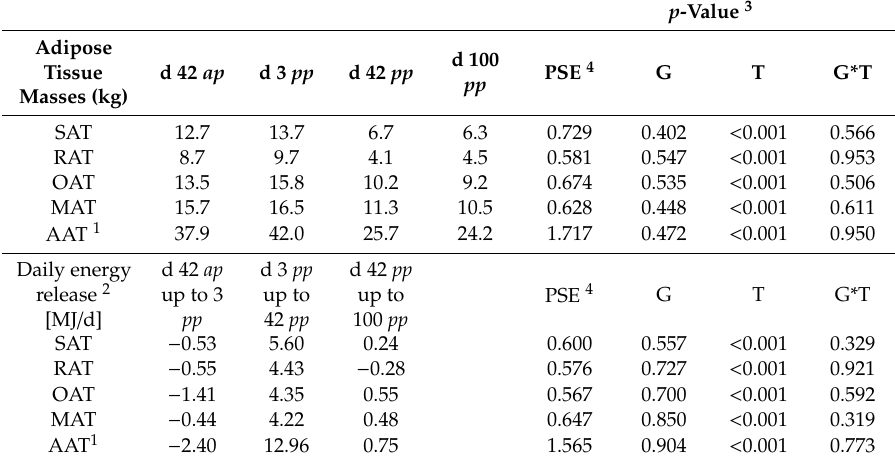
Table A8. E ff ects of L-carnitine supplementation on ultrasonically determined subcutaneous (SAT), retroperitoneal (RAT), omental (OAT), mesenteric adipose tissue (MAT) and calculated total abdominal adipose tissue (AAT) as well as daily derived energy release for each of the mentioned fat depots. p -Value